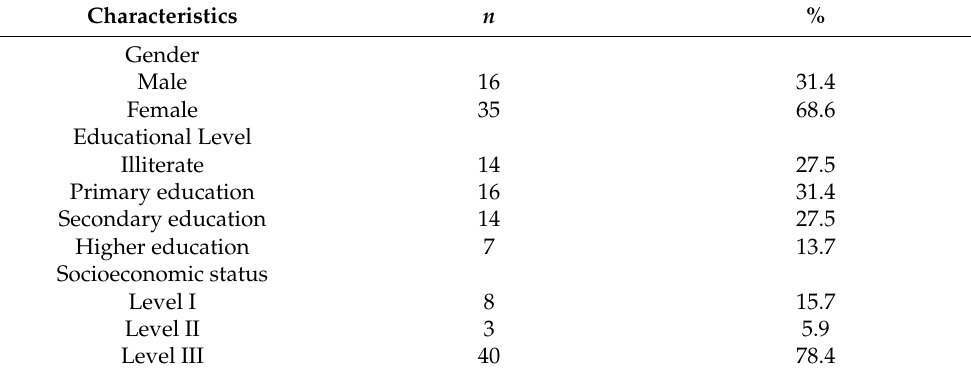
Table 1. Demographic characteristics of the sample ( n =